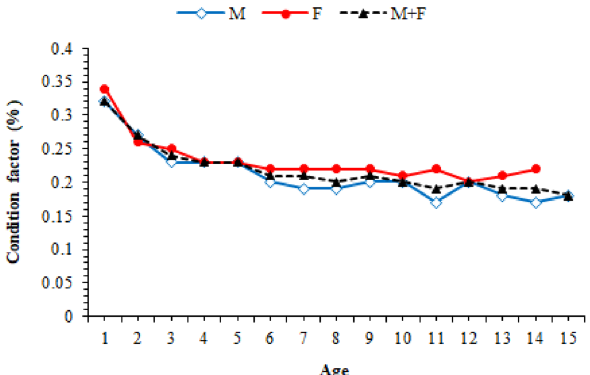
Figure 5. The of condition factor distributions of M. mastacembelus population inhabiting Keban Dam Lake.